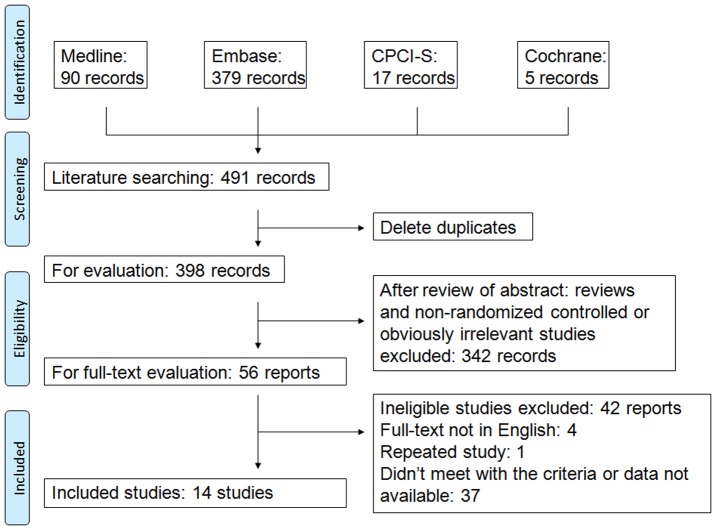
Flow diagram of study identification.